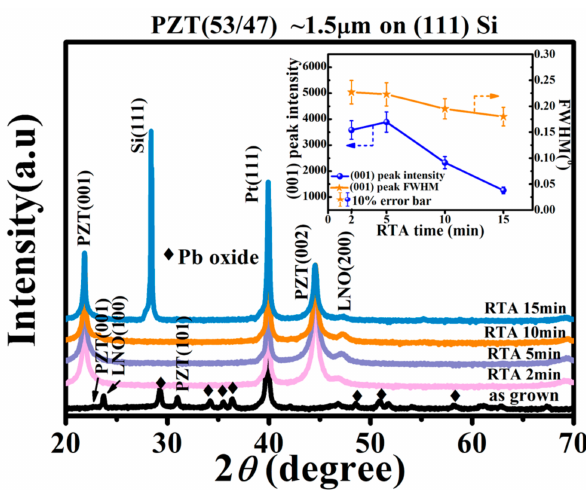
Figure 2. XRD θ -2 θ scan patterns of the PZT films deposited on (111) Si before and after the RTA process with different annealing times. The inset shows the (001) PZT peak intensity and full width at half maximum (FWHM) as functions of the annealing time.